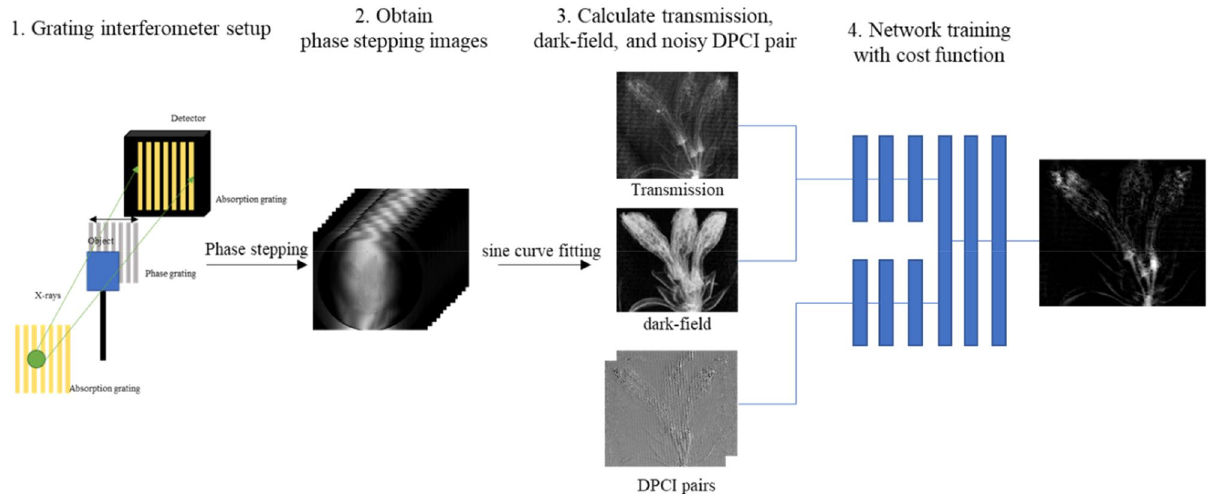
Figure 2. Schematic of deep learning-based phase retrieval in grating